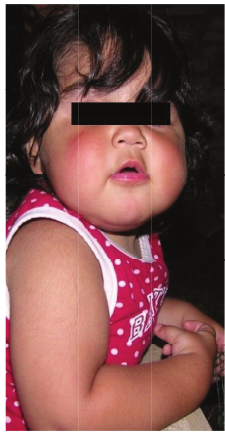
Figure 1: A 5-year-old girl with Cushing Syndrome due to adrenal adenoma that we followed up at our Institution (University of Messina) for sleep disturbances and mood disorders. Note the characteristic facial